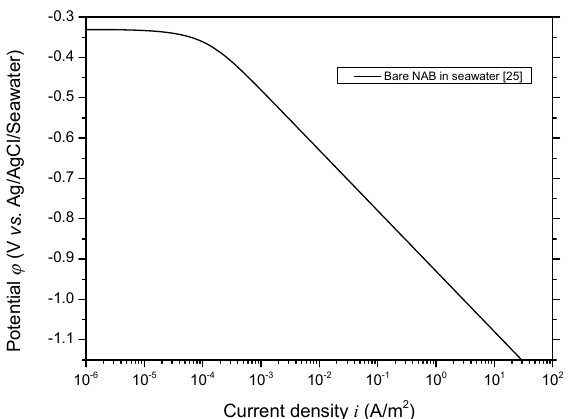
Figure 5. Polarization curve (only the cathodic branch) of bare nickel-aluminum-bronze (NAB) alloy in seawater.